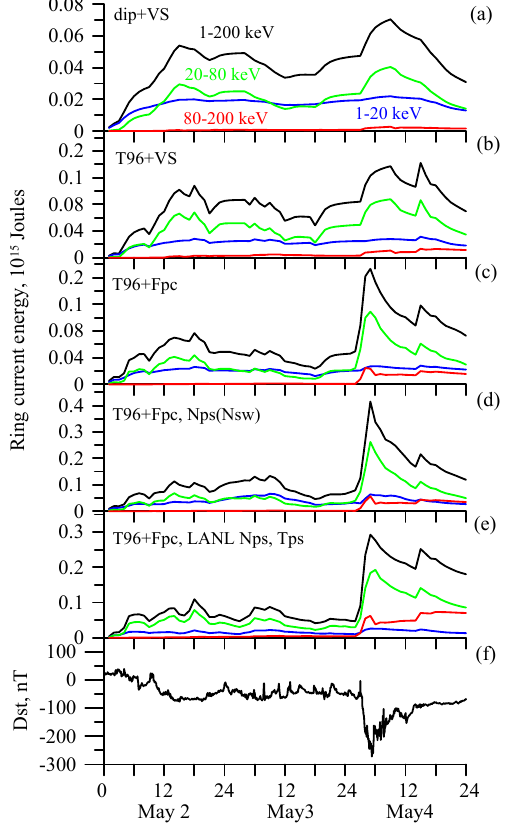
Fig. 5. Calculated proton ring current energy in Joule for total (1–200keV, black curves), low (1–20keV, blue curves), medium (20–80keV, green curves) and high energies (80–200keV, red curves) while tracing in ( a ) dipole magnetic field and Volland-Stern electric field with constant plasma sheet number density and aver- age temperature as initial conditions, ( b ) Tsyganenko T96 magnetic field instead of dipole, ( c ) Boyle et al. (1997) polar cap potential ap- plied to Volland-Stern model instead of Volland-Stern electric field, ( d ) Tsyganenko T96 magnetic field and Boyle et al. (1997) polar cap potential applied to Volland-Stern model with the plasma sheet number density dependent on the solar wind number density and average temperature as initial conditions, and ( e ) with the plasma sheet number density and average temperature obtained from corre- sponding LANL particle measurements, together with the measured D st index ( f ) for 2–4 May 1998.